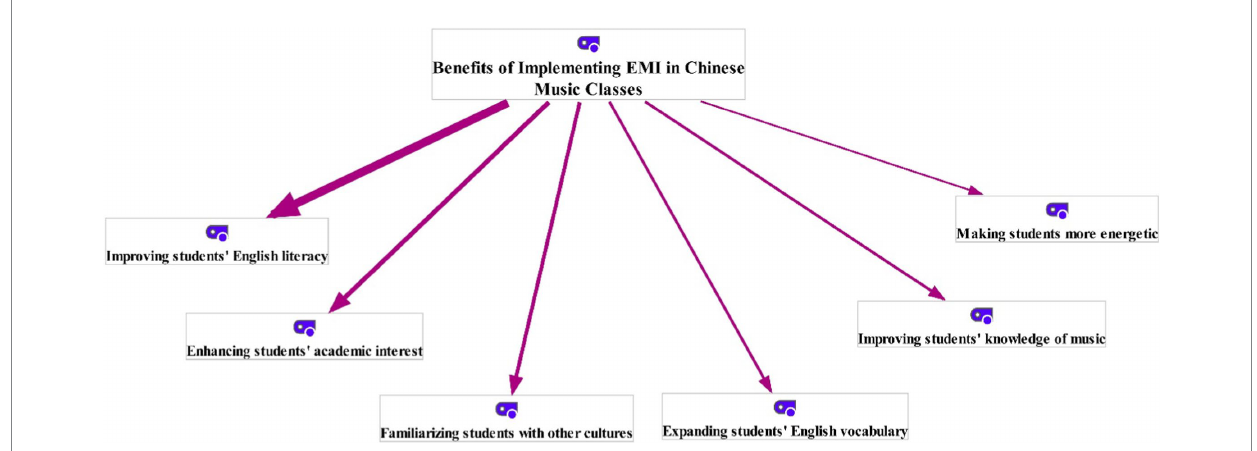
FIGURE 1 Benefits of implementing English as a medium of instruction (EMI) in Chinese music classes (the thicker the line, the more recurrent the